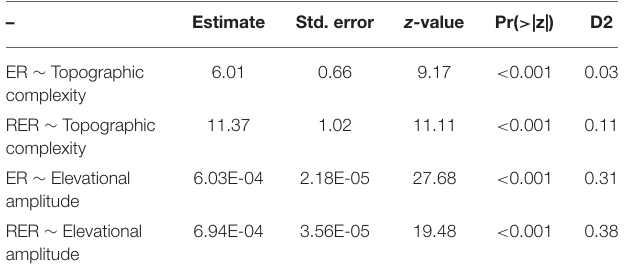
TABLE 1 | Relationships between Endemic Richness (ER) and Range-restricted Endemic Richness (RER) per raster-cell using Generalized Linear Models (GLM) with a Poisson distributed response (species richness) and the canonical log link-function.